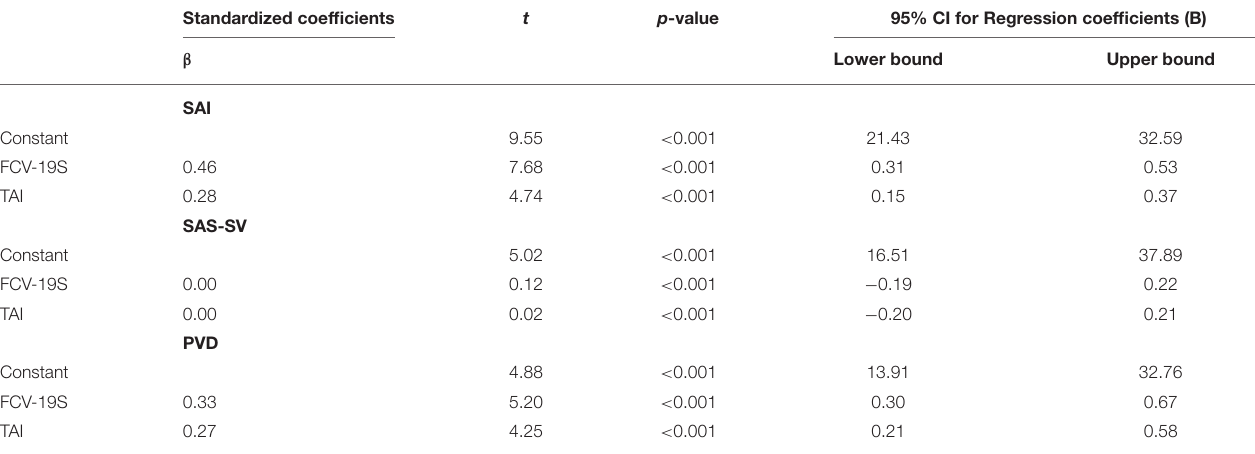
TABLE 3 | Linear regression model between the independent variables (i.e., FCV-19S and TAI) and dependent variables (i.e., SAI, SAS-SV, and PVD) with 95% bias-corrected and